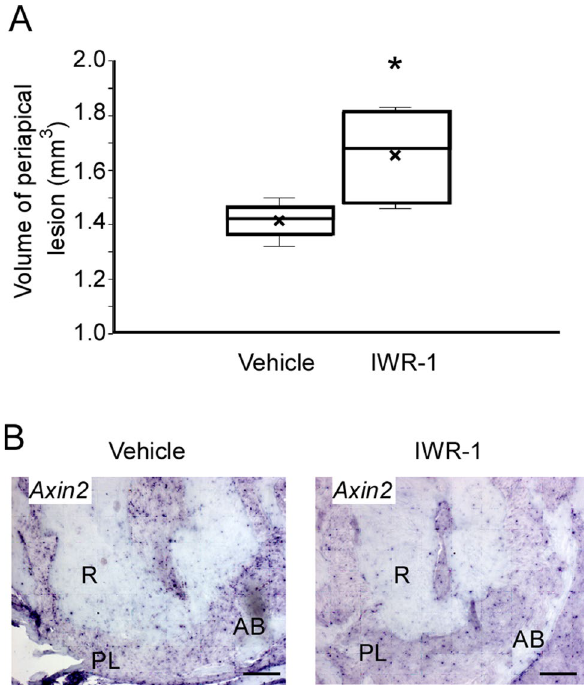
Figure 2. IWR-1 injection inhibited the Wnt/β-catenin signaling pathway and spread the periapical lesion. ( A ) The quantification of periapical lesion volumes of the vehicle group (white bar, mean ± SD, n = 4) and the IWR-1 treatment group (black bar, mean ± SD, n = 4). Two-tailed paired Student’s t test, * P < 0.05. ( B ) In situ hybridization for Axin2 in the periapical lesion at 4 weeks after chamber opening. R root, PL periapical lesion, AB alveolar bone. Scale bars = 100